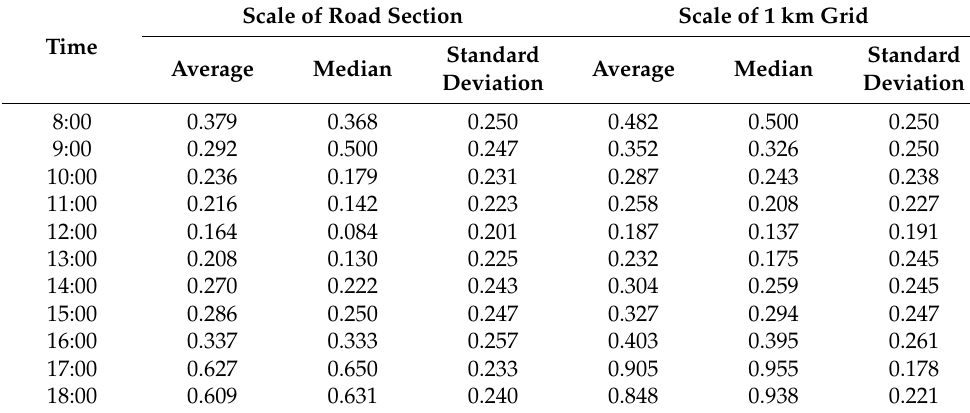
Table 2. The statistical values of shading coverage index.